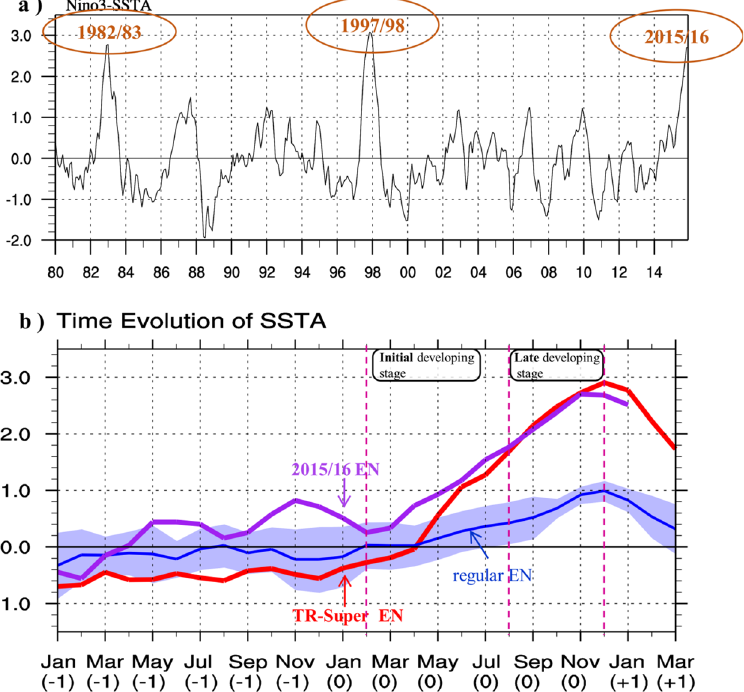
Figure 1. ( a ) Time series of the sea surface temperature anomaly (SSTA) averaged over Niño3 (i.e., Niño3 index) from ERSST. Here Niño3 region is bounded by 5°S-5°N and 150°W-90°W. ( b ) Temporal evolution of Niño3 SSTA. Purple line indicates the 2015/16 El Niño (i.e., 2015EN), red line indicates the composite of traditional super EN events (i.e., 1982/83 EN and 1997/98 EN), and the blue line indicates the composite of the regular EN events during 1980–2015 (including 1986/87, 1987/88, 1991/92, 1994/95, 2002/03, 2004/05, 2006/07 and 2009/10 ENs). The light blue shading indicates the inter-case spread, which is estimated with the inter- case standard deviation of the regular EN events. The magenta dashed lines divide the development of 2015EN into two stages, i.e., the initial developing stage (FMAMJJ[0]) and the late developing stage ([ASON[0]]). Here year[0] and year[ − 1] indicate the year of an EN event and the preceding year, respectively. This figure was generated by the NCAR Command Language (NCL, version 6.2.1, [Software]. (2014). Boulder, Colorado: UCAR/NCAR/CISL/VETS. http://dx.doi.org/10.5065/D6WD3XH5) and the licensed Microsoft